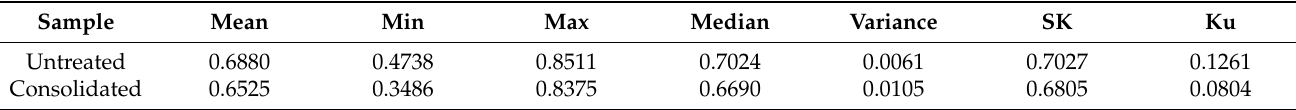
Table 3. Comparison of sphericity distribution of